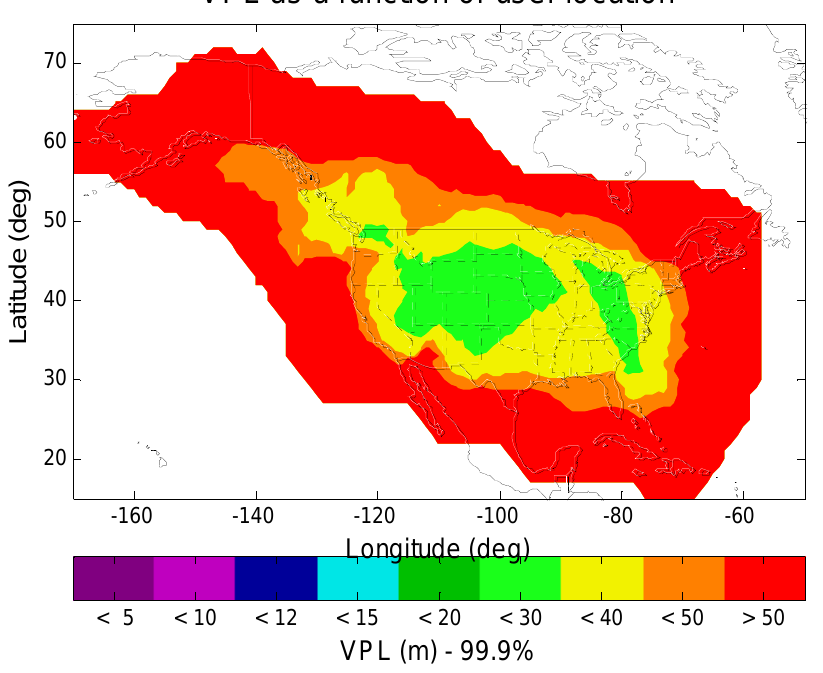
Figure 2. The 99.9% VPL contour of IOC WAAS. The VPL values in CONUS are greater than 20 m, and some places are higher than 50 m (LPV